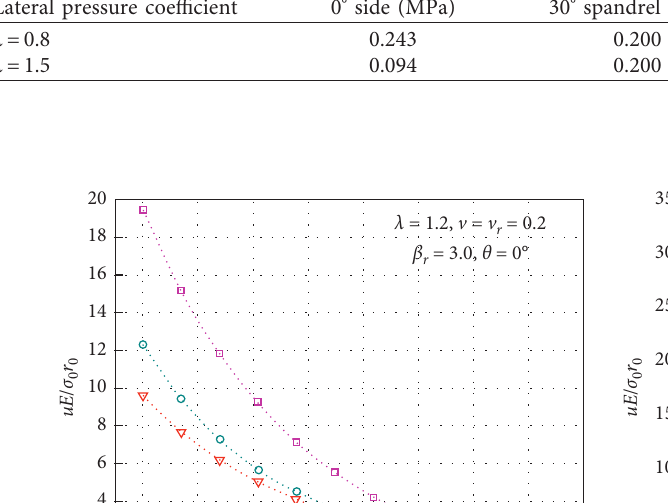
Table 2: The changes of critical support resistance ( p Lateral pressure coefficient